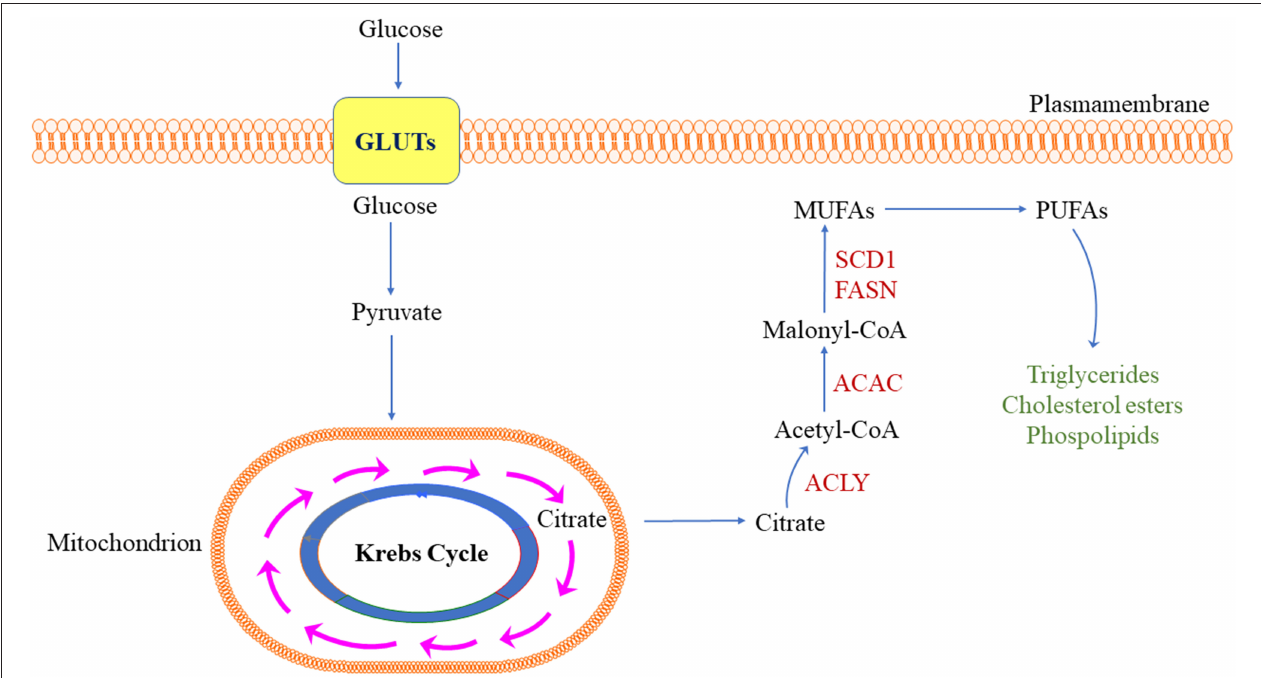
FIGURE 1 | Simplified representation of de novo lipogenesis in the tumor cell. ACC, acetyl-CoA carboxylase; ACLY, adenosine triphosphate citrate lyase; FASN, fatty acid synthase; GLUTs, glucose transporters; MUFA, monounsaturated fatty acids; PUFA, polyunsaturated fatty acids; SCD1, stearoyl-CoA desaturase 1. Detailed description of the pathway is reported in the main